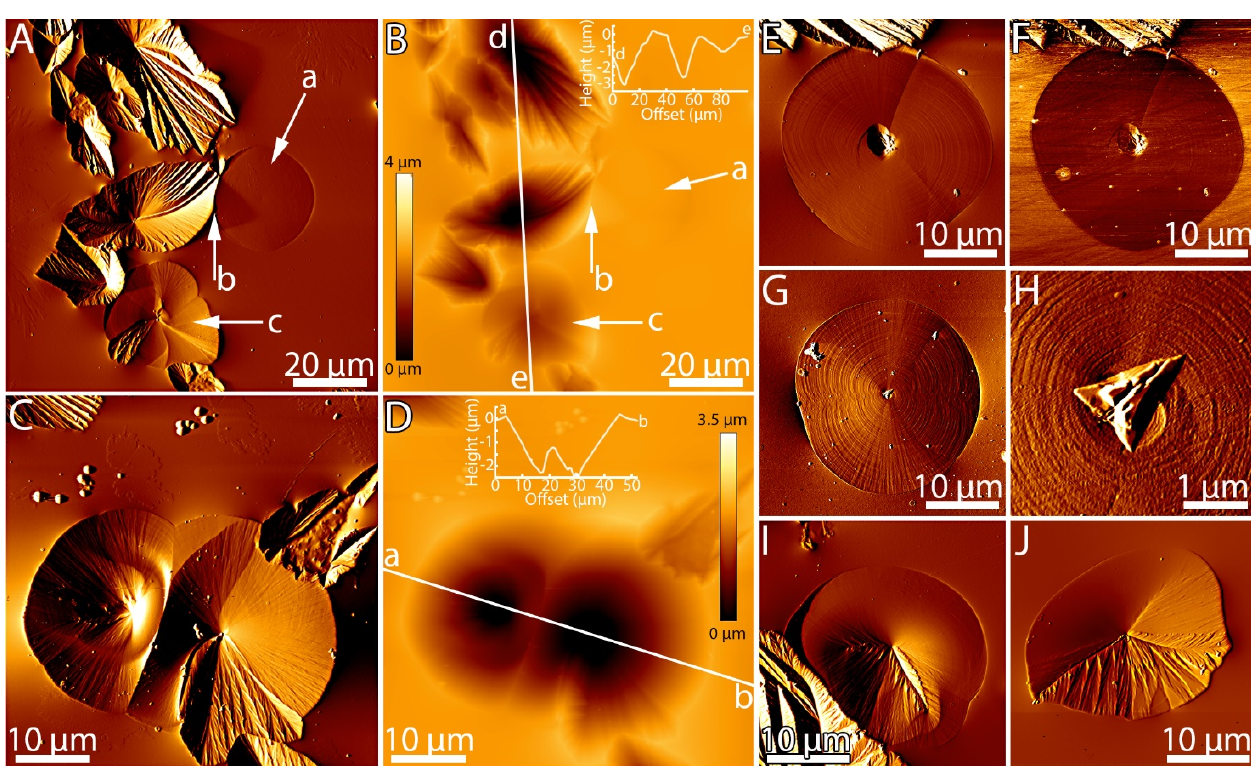
Figure 4. LSM 3D-images of crystallized surfaces in dry air ( A ), argon ( B ) and vacuum ( C ). The crystals and circular structures of the air and argon samples grow toward the bulk of the samples and form valleys. In vacuum, the crystals are the plateaus and the surrounding residual glassy ma- trix forms holes. Some branched crystals in argon atmosphere protrude from the surface.